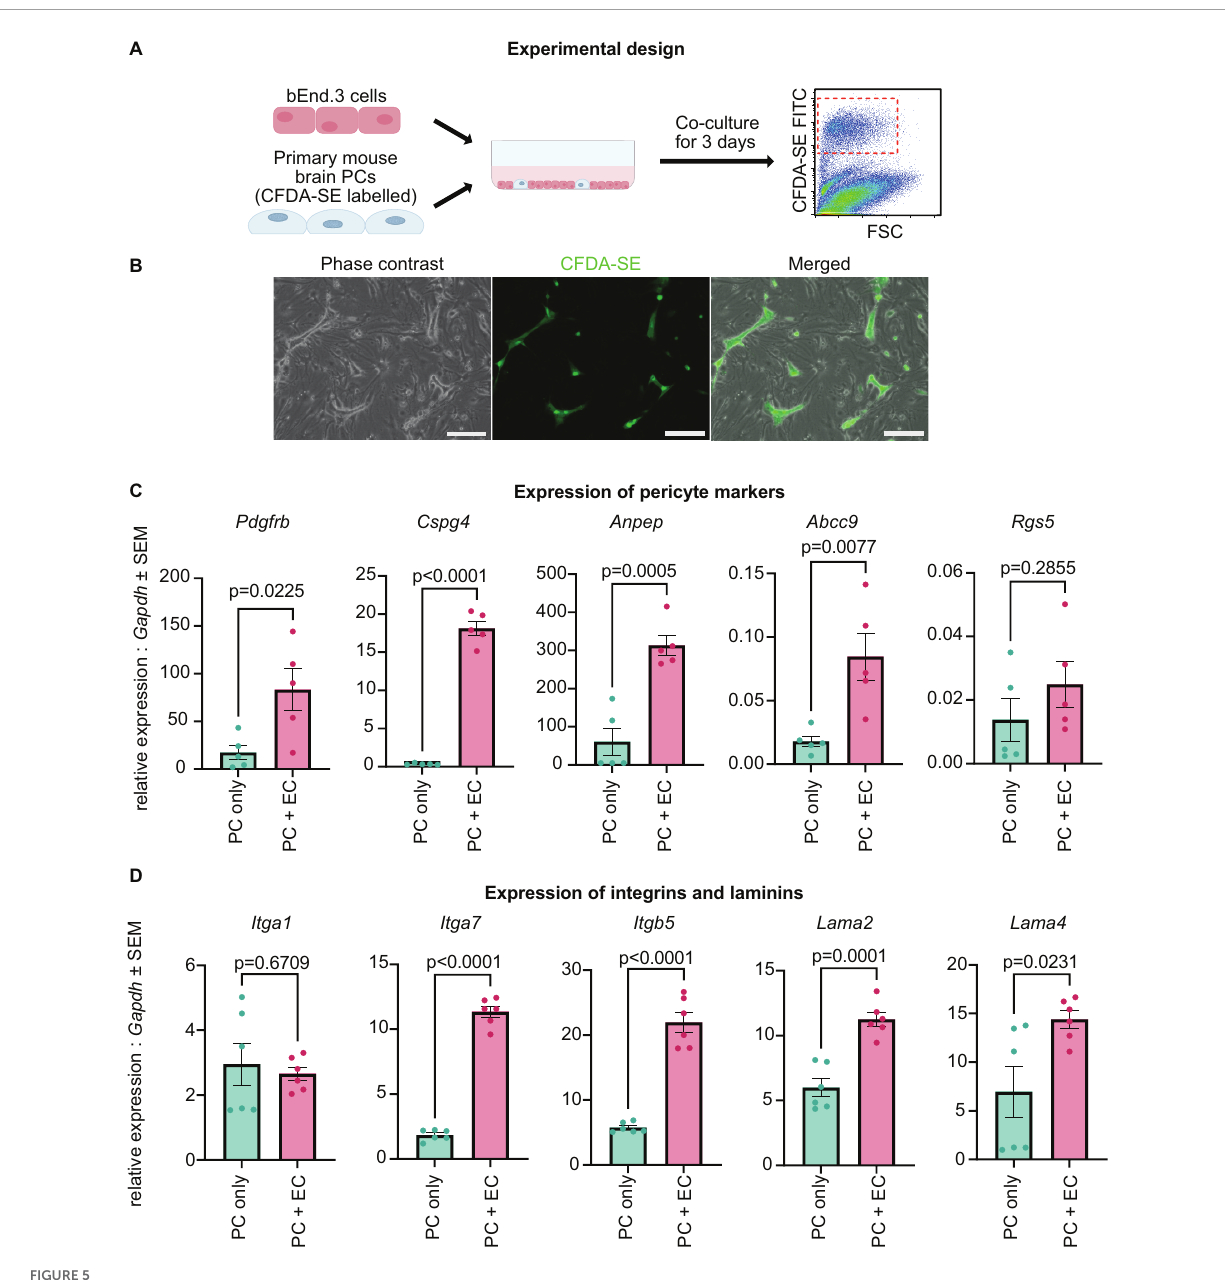
FIGURE5 Canonical PC markers and ECM genes are upregulated with brain EC co-culture. (A) Experimental design: primary brain PCs were labeled, co-cultured with bEnd.3 cells for 3 days, isolated by FACS sorting, and analyzed via qRT-PCR. (B) Localization of stained PCs within the co-culture with bEnd.3 cells. Scale bar, 200 µ m. (C) Expression levels of Pdgfrb , Cspg4 , Anpep , Abcc9 , and Rgs5 in PCs cultured alone (PC only) and co-cultured with bEnd.3 cells (PC + EC). The data were normalized to Gapdh and analyzed with a two-sided Student’s t -test. Data are presented as mean ± SEM. The experiment was repeated 5 times, with each data point indicating a replicate. (D) Expression levels of Itga1 , Itga7 , Itgb5 , Lama2 , and Lama4 in PCs cultured alone (PC only) and co-cultured with bEnd.3 cells (PC + EC). The data were normalized to Gapdh and analyzed with a two-sided Student’s t -test. Data are presented as mean ± SEM. The experiment was repeated 6 times, with each data point indicating a replicate.